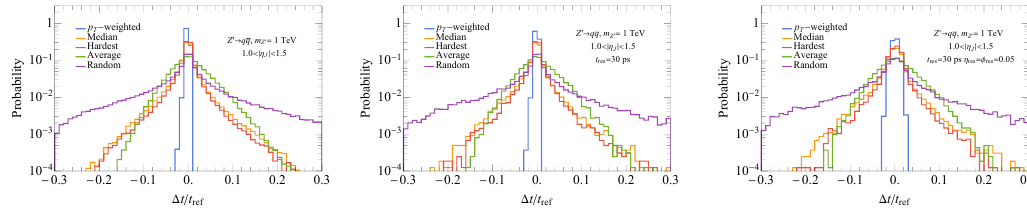
Figure 17 . The relative time difference distribution for 1 . 0 < | η J | < 1 . 5 with no detector effects (left), with time resolution added (center), and with time and spatial resolution added (right).